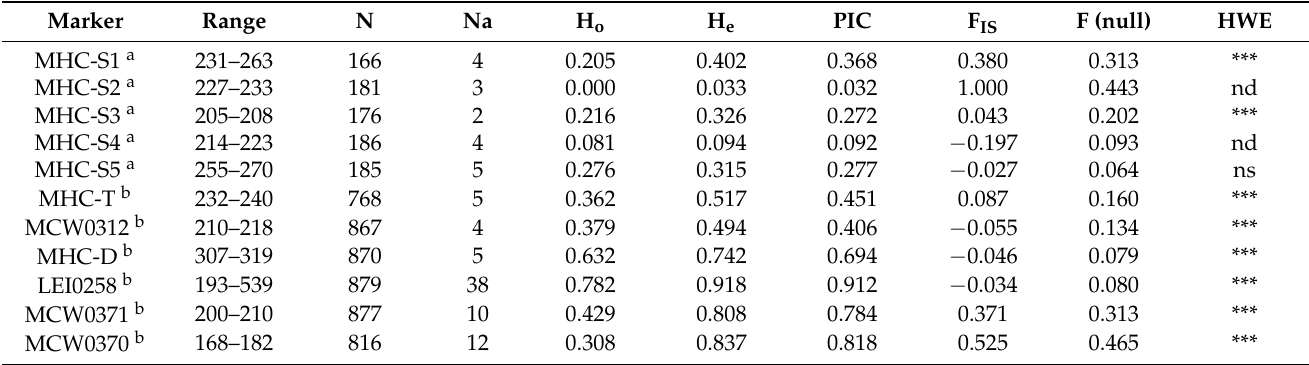
Table 1. Summary of 11 microsatellite markers used in this